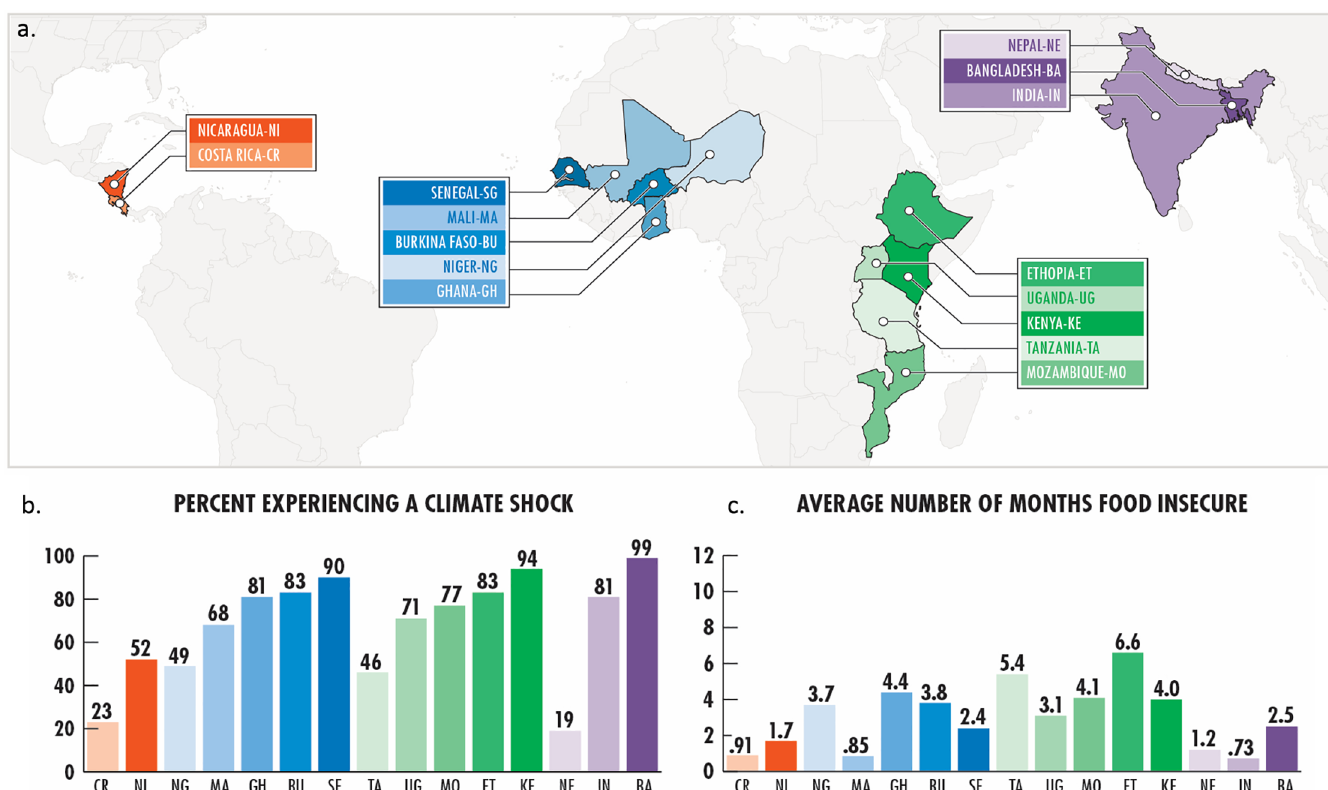
Fig 1. Country and region food insecurities and climate shocks. Households included in the study (Fig 1A) across four regions and 15 countries are color-coded by geographic region and shading represents intensity within the region scaled on the percent of households that faced a climate shocks (Fig 1B). Average rates of food insecurity are listed by country (Fig